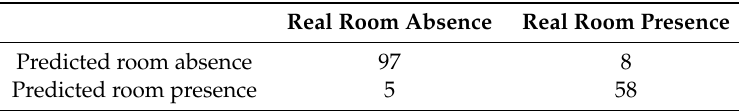
Table 4. Contingency table for the opened window classifier.